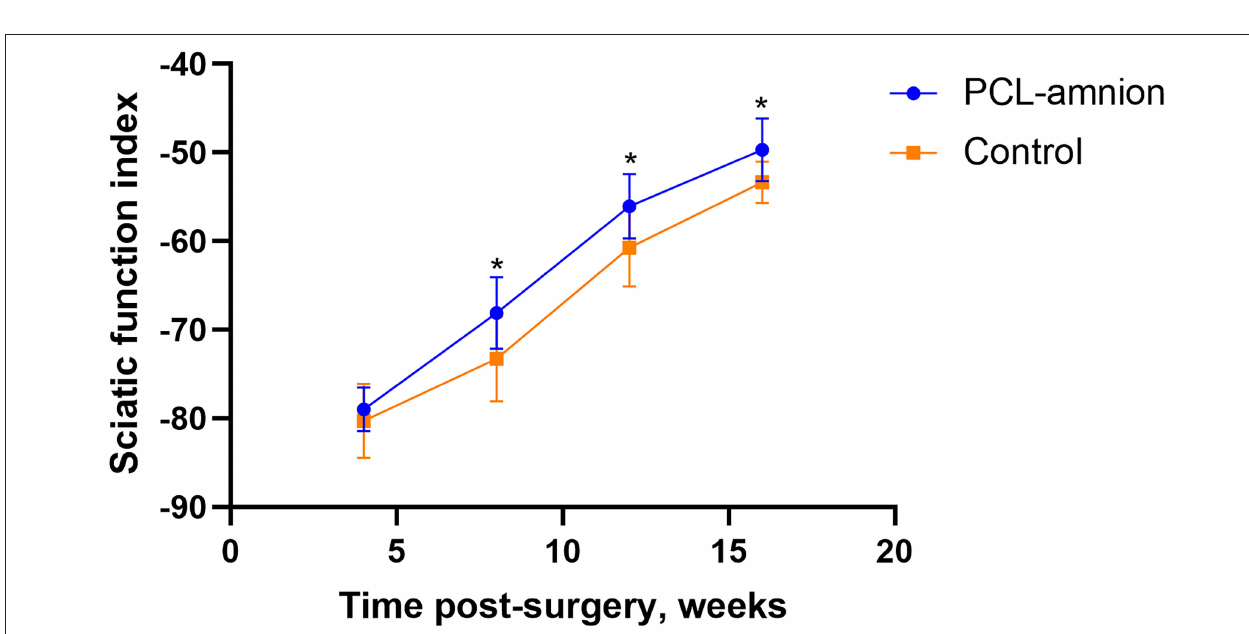
FIGURE 5 | Sciatic function index. The SFI between the two groups was significantly different at 8, 12, and 16 weeks ( P < 0.05). * P < 0.05 compared to the control